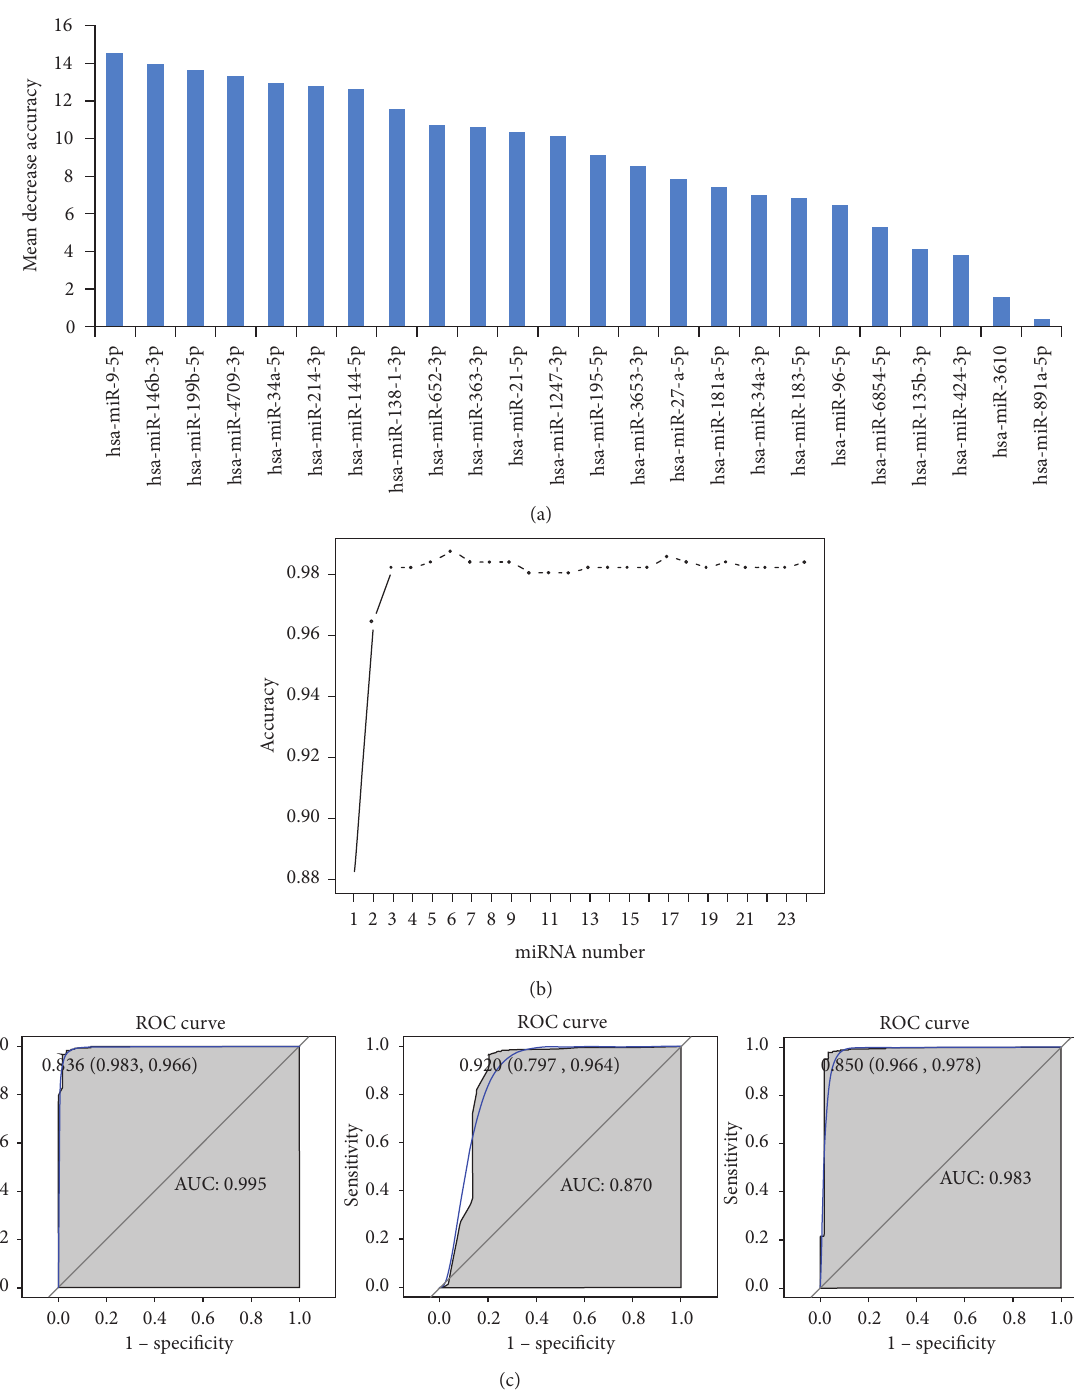
Figure 3: Identification of optimal diagnostic miRNAs biomarkers for PTC based on RF, DT, and SVM classification models. (a) The ranking of all miRNAs. miRNAs were ranked according to the standardized drop in prediction accuracy. (b) The tendency chart of AUC along with the increase of miRNAs. (c) ROC results of combinations of 6 optimal diagnostic lncRNAs